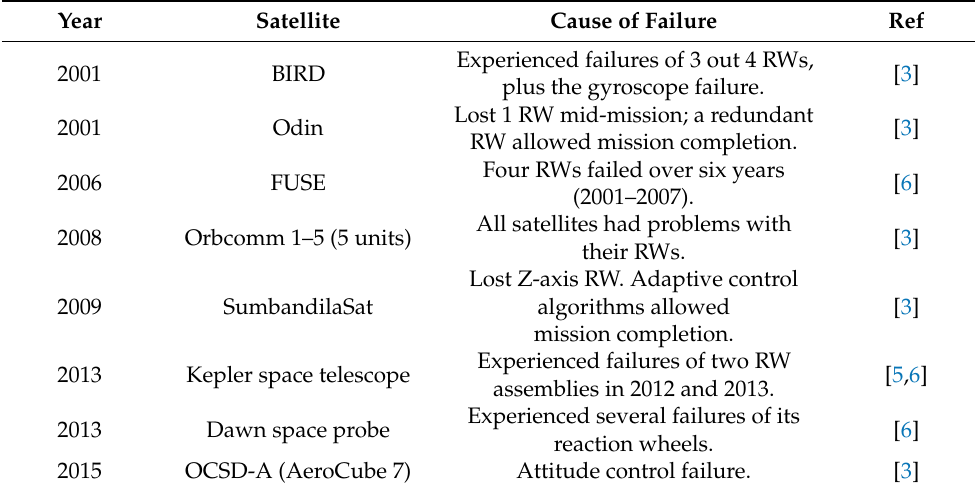
Table 1 lists more examples of RWs and ACS failures. Table 1. Samples of ACS and RW